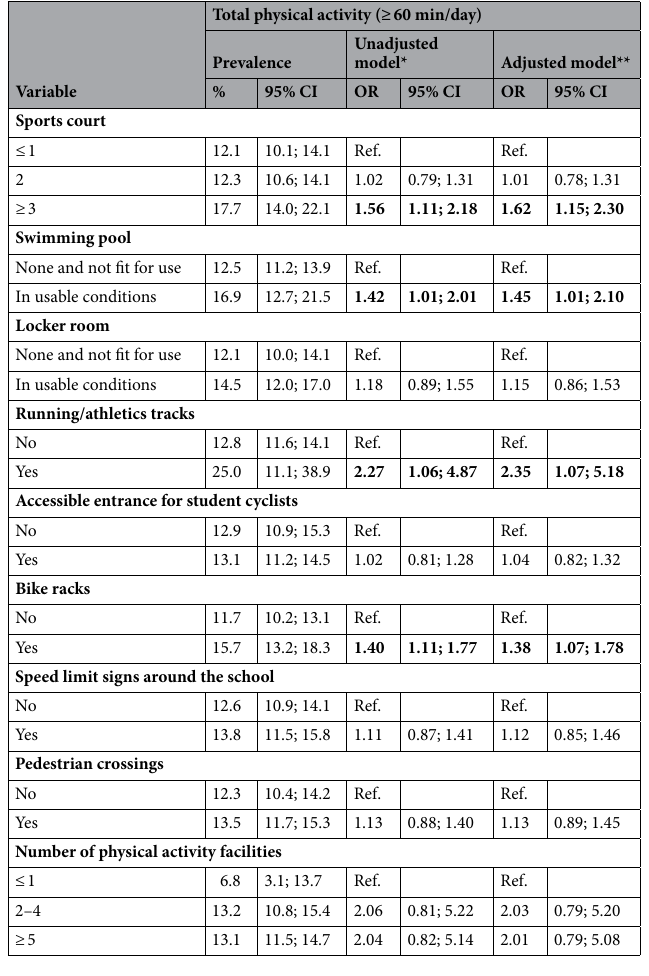
Table 3. Association between school environment and total physical activity in adolescents. Values in bold indicate significant associations; 95% CI 95% confidence intervals, OR odds ratio. *Number of adolescents enrolled in the school as first level and type of school as second level. **Number of adolescents enrolled in the school as first level, type of school as second level, adjusted by sex, age (years), skin color/ethnicity, and mother’s employment